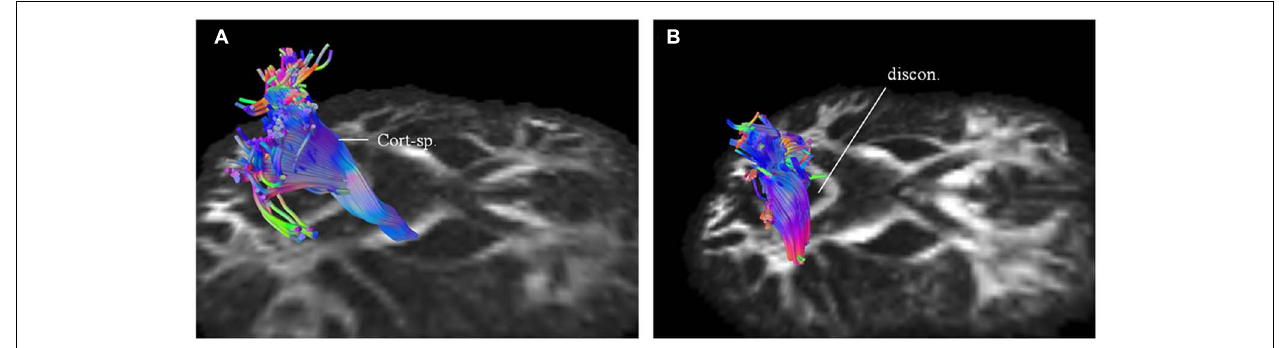
FIGURE 6 |Targeted fiber tracking in patient 1 demonstrated evidence of progressive compromise of the right corticospinal tract (Cort-sp.) between the baseline scan (A) and the subsequent scan (B), a year later, on which discontinuity (discon.) in the caudal segment was noted.